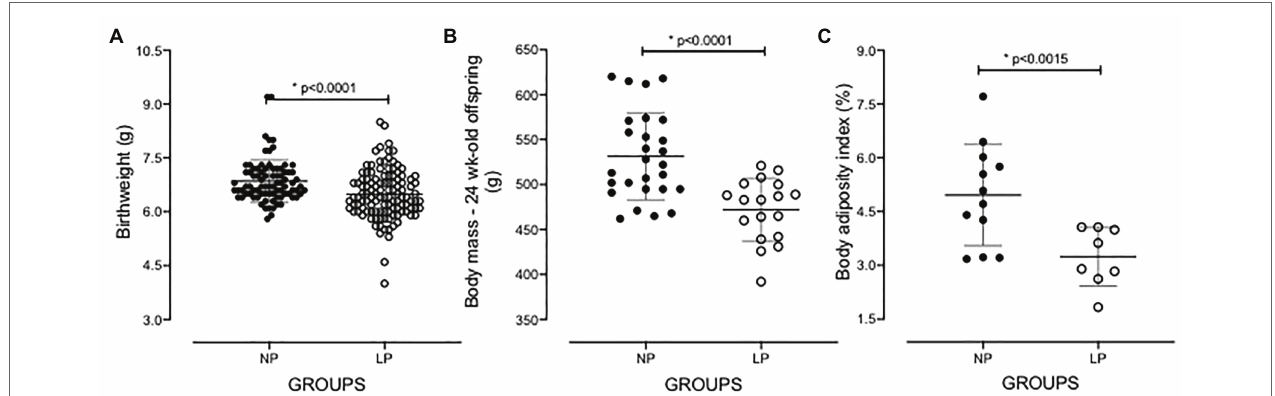
FIGURE 1 | The low-protein (LP) and NP birthweight ( A ; LP: n = 117; NP: n = 84), and body weight ( B ; LP: n = 18; NP: n = 27) and body adiposity index ( C ; LP: 18; NP: n = 27), in grams, of 24-week-old protein-restricted (LP) progeny compared with age-matched standard (NP) progeny. Data are presented as scatter dot plots; Welch’s t -test was used for data analysis. The level of significance was set at p <